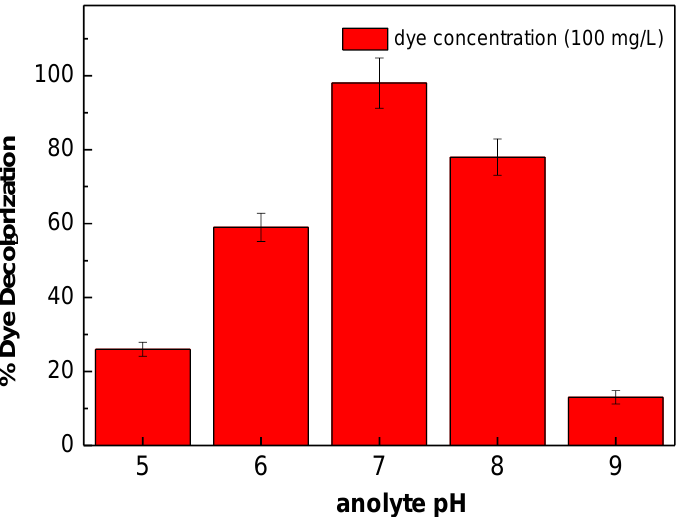
Figure 2. Initial and final absorbance of Congo red dye at different pH and 100 mgL −1 substrate concentration at their respective maximum wavelengths.